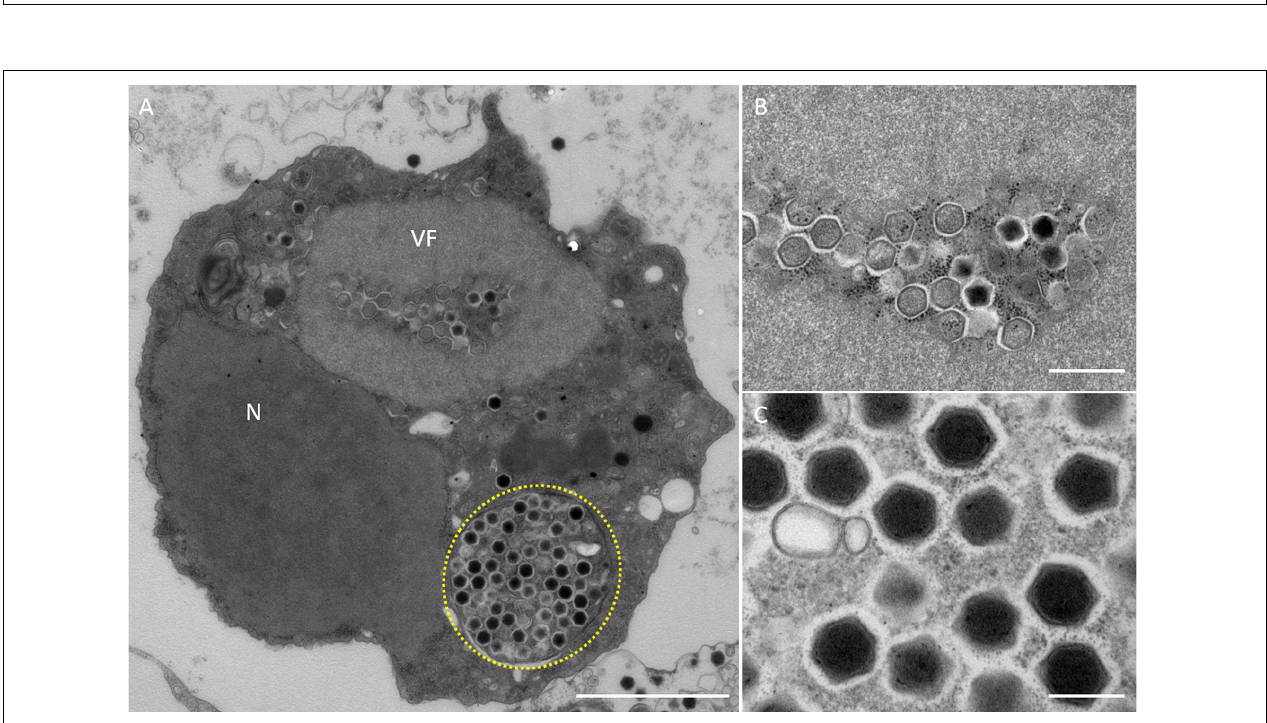
FIGURE 3 | TEM images of ultrathin sections of amoeba cells infected with the new viruses isolated from the Ukawa River (named kashiwazakivirus). (A) TEM image of a typical virion factory (VF) in the cytoplasmic region of the amoeba cells. N indicates an amoeba cell nucleus. Yellow circle indicates membrane bag. Scale bar: 2 µ m. (B) Enlarged image of virus particles in VF of panel (A) . Scale bar: 500 nm. (C) Enlarged image of viral particles in the amoeba cytoplasm. Scale bar: 200 nm.